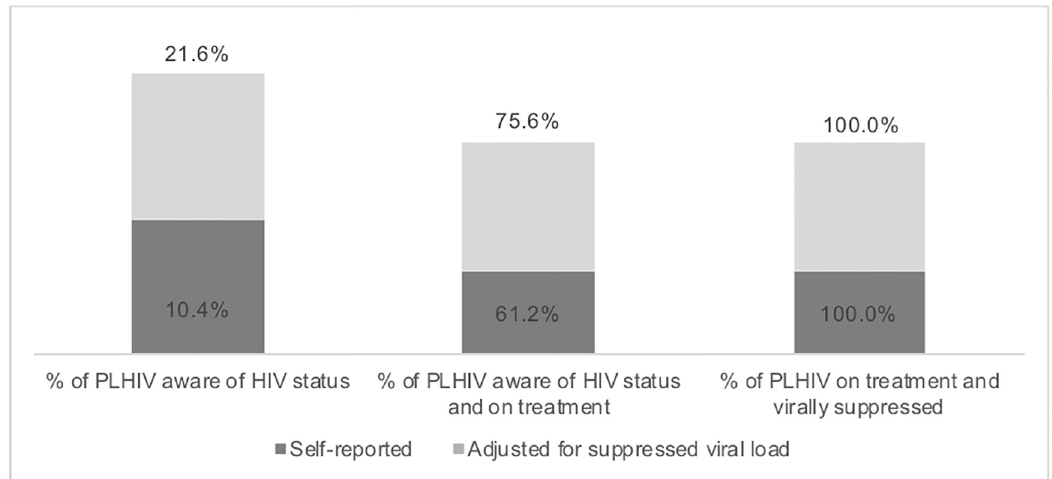
Fig 1. 90-90-90 cascade among HIV-positive MSM and TGW in Bamako, Mali 2014–2015.